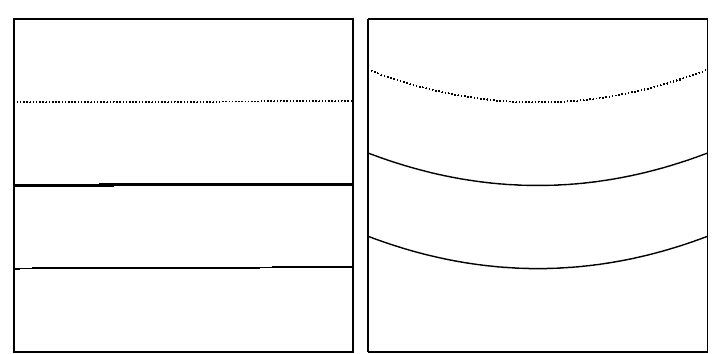
Fig. 2. Star tracks in the focal plane of the “Lyra-B” telescope. Left: scanning in the orbital plane, star tracks are practically rectilinear; right: scanning of the circumpolar region, star tracks are appreciably curved (the curvature of the tracks is increased by a factor of 30).